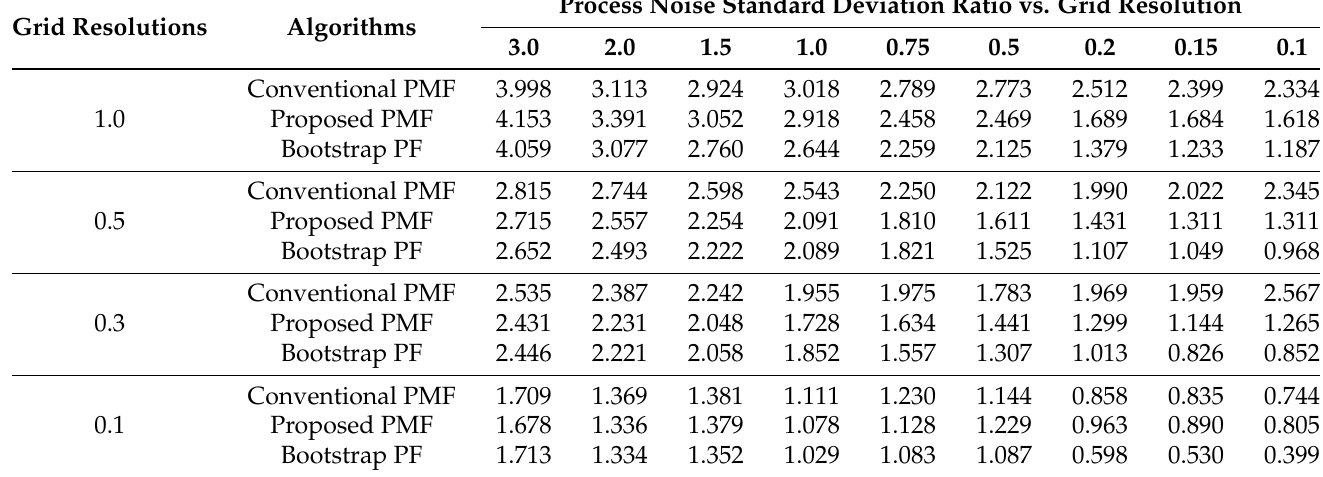
Table 1. Estimation errors of the conventional PMF, the proposed PMF, and PF for various grid intervals and process noise variances. Grid